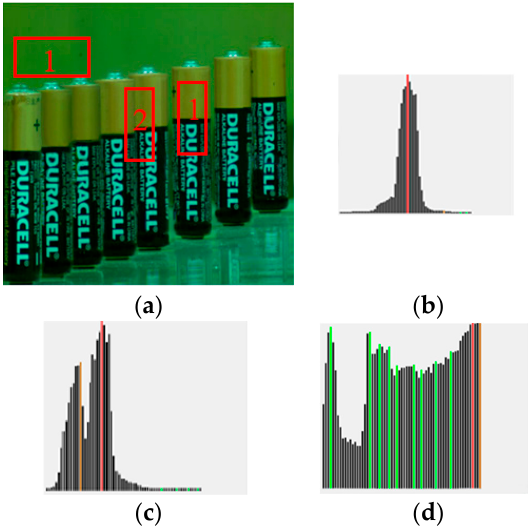
Figure 2. The shape of a focus profile 𝐹𝑃 𝑠 , ( a ) Regions 1,2, and 3 for analysis, ( b ) single peak corresponding to region 1, ( c ) two-peak corresponding to region 2, ( d ) multi-peak corresponding to region 3.